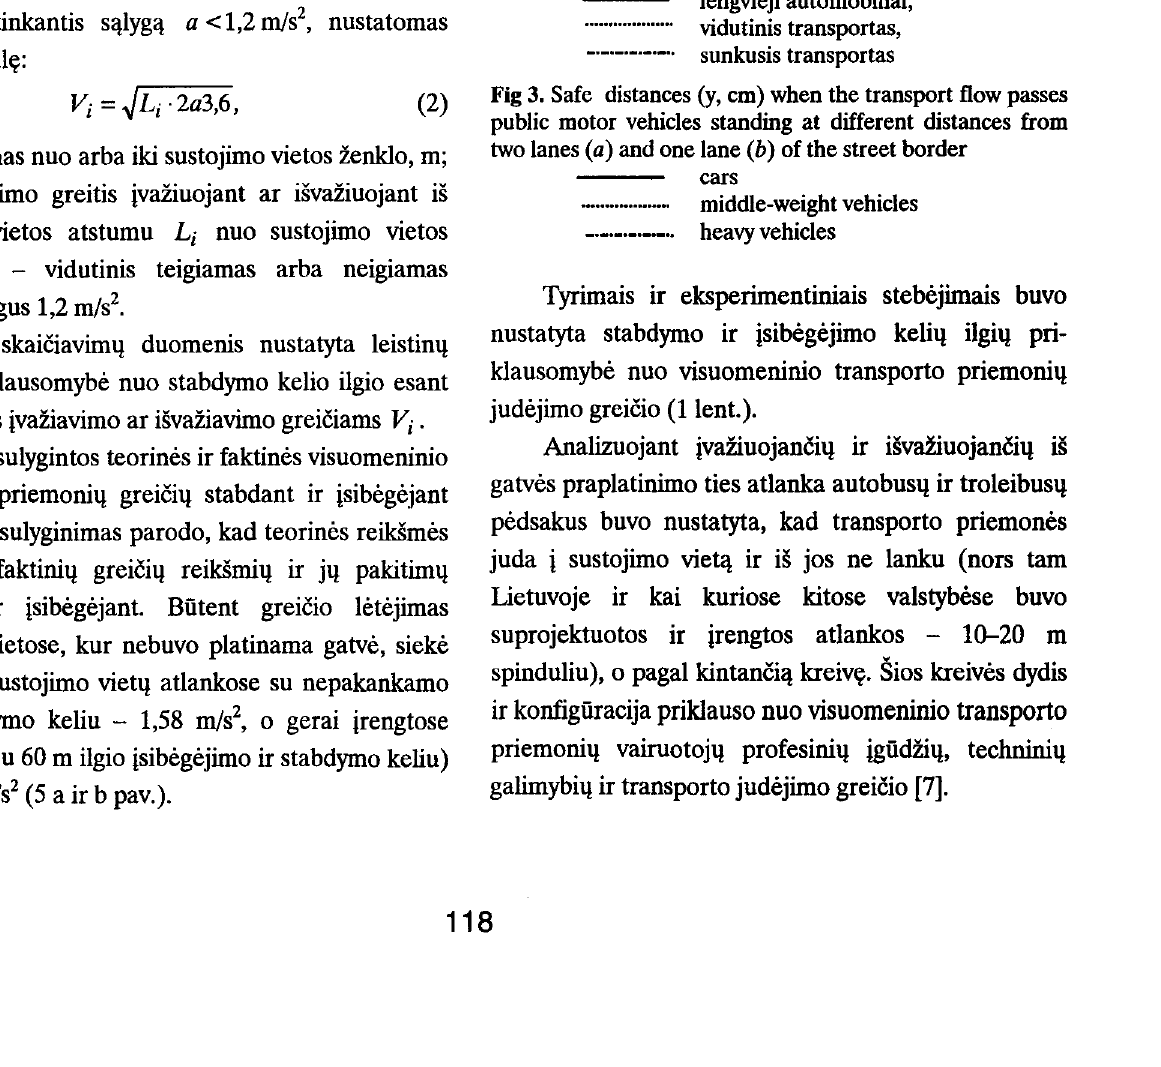
Fig 3. Safe distances (y, em) when the transport flow passes public motor vehicles standing at different distances from two lanes (a) and one lane (b) of the street border